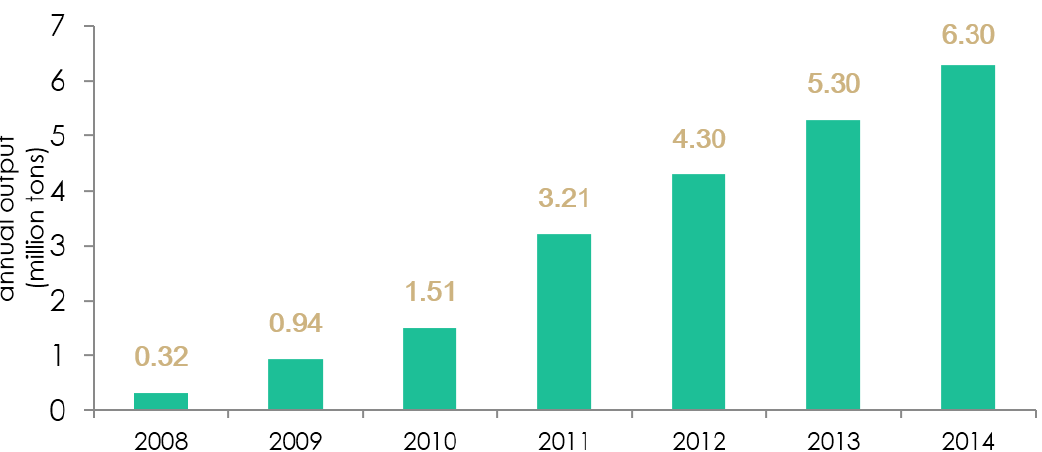
Figure 2. Annual BMF outputs (2008–2014) (source: the Energy Research Institute of the National Development and Reform Commission of